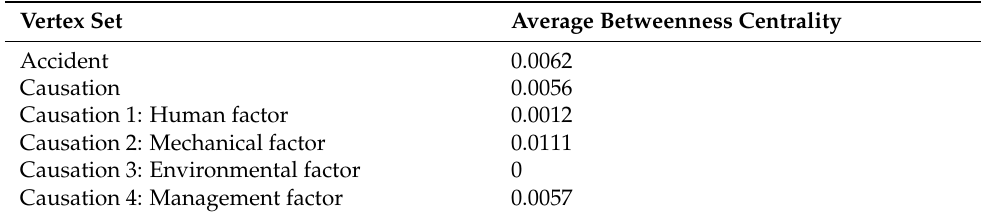
Table 6. The average betweenness centrality of various types of vertex